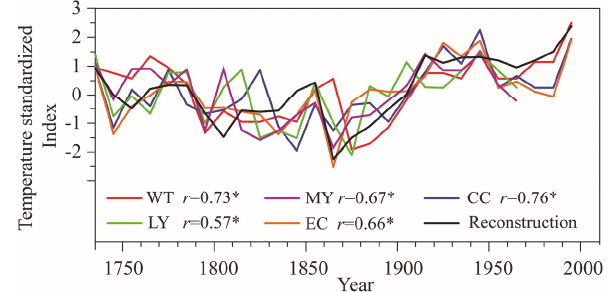
Fig. 3. Comparison between different reconstructions from histori- cal documents and our reconstruction. Asterisk (*) indicates that the correlation coefficient between the two reconstructed series passed the α =0.01 significance level. EC is the winter temperature over East China (Wang and Wang, 1990); CC is the annual temperature in Central China (Wang et al., 1998); MY and LY are winter temper- ature indices in the Middle of the Yangtze River and Lower reaches of the Yangtze River, respectively (Zhang et al., 1980); and WT is the winter half-year temperature in Eastern China (Ge et al.,